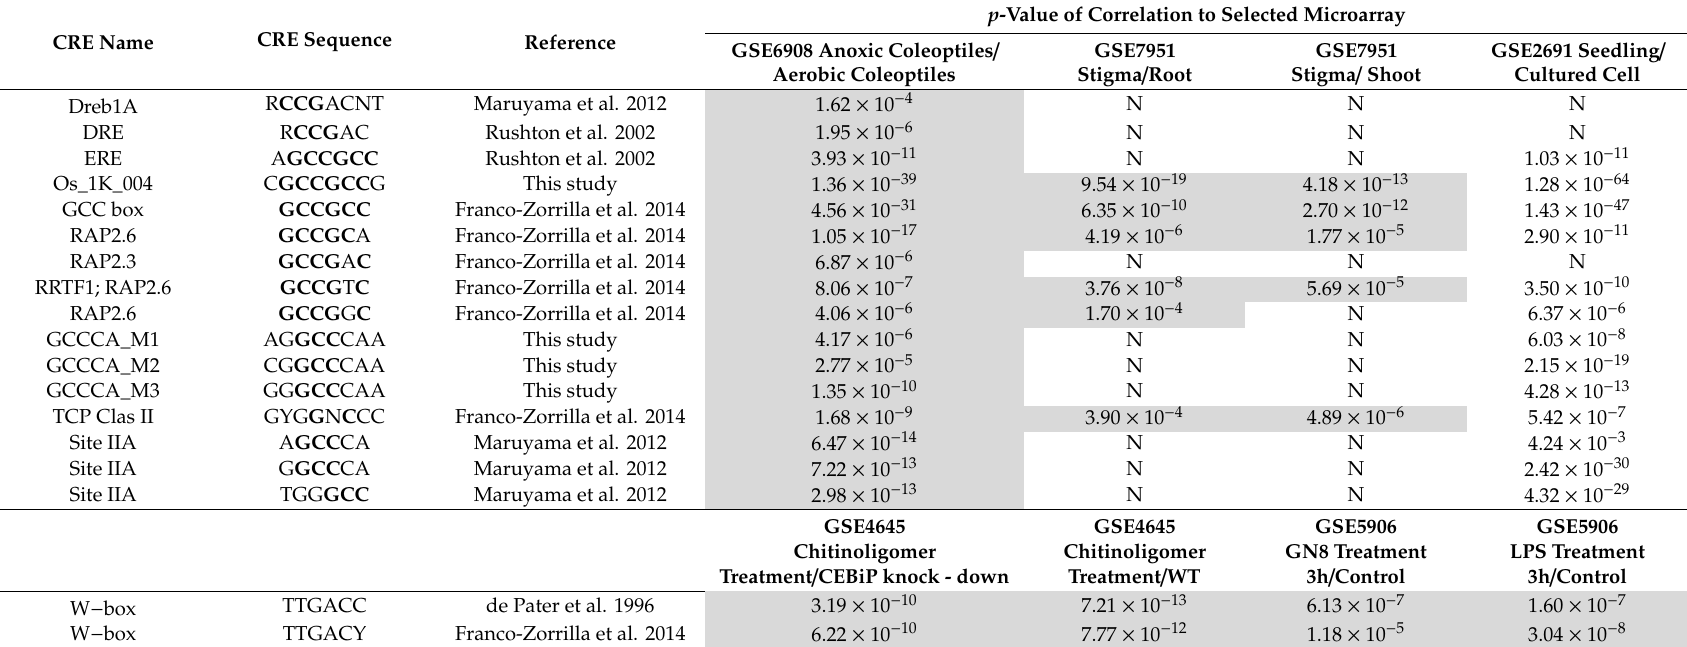
Table 2. CREs with ABRE core and CE and their correlation to related